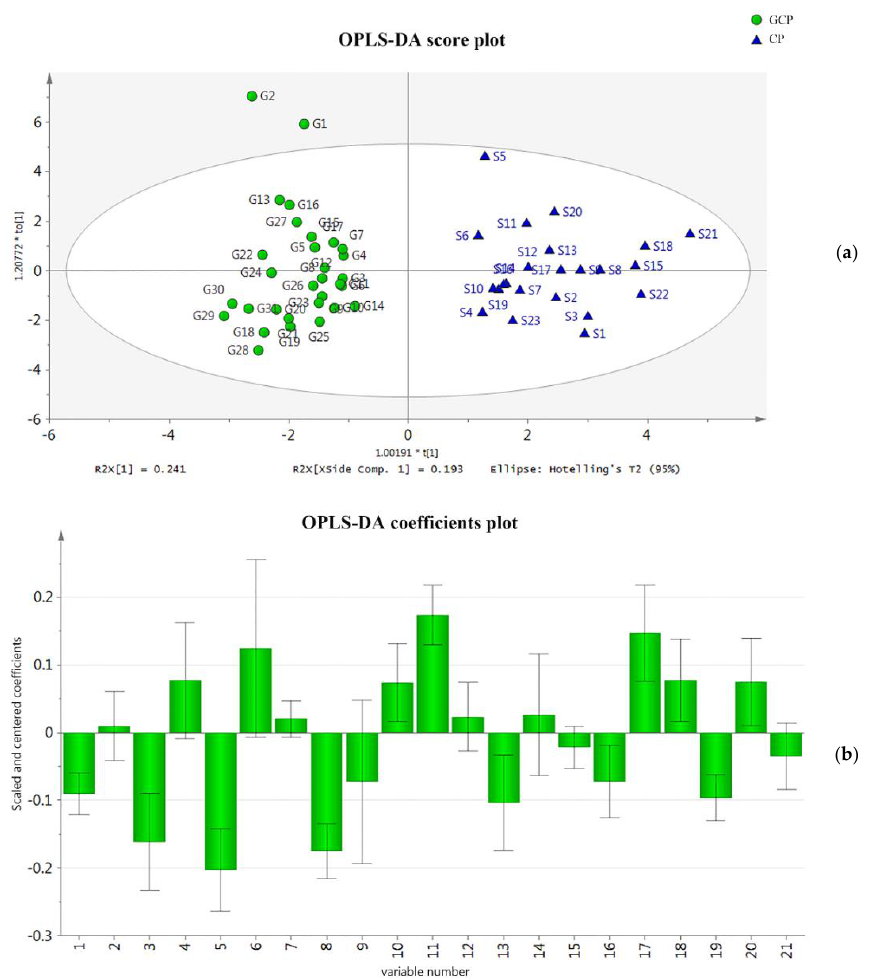
Figure 3. Orthogonal partial least-squares-discrimination analysis (OPLS-DA) models for the classification of CRP. ( a ) Score plot of the OPLS-DA results. Circles represent GCP samples, and triangles represent CP samples. ( b ) Plot of the coefficients for the OPLS-DA. The constant not displayed in the plot was 1.150.